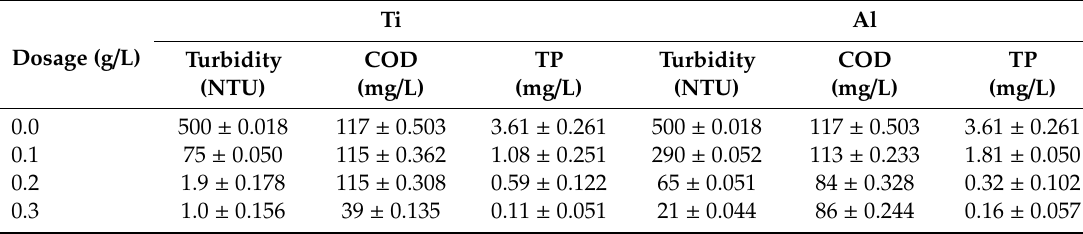
Table 1. Turbidity, COD and TP results with di ff erent concentrations of TiCl 4 (as Ti) and poly aluminum chloride (PAC) (as Al) in algal turbid